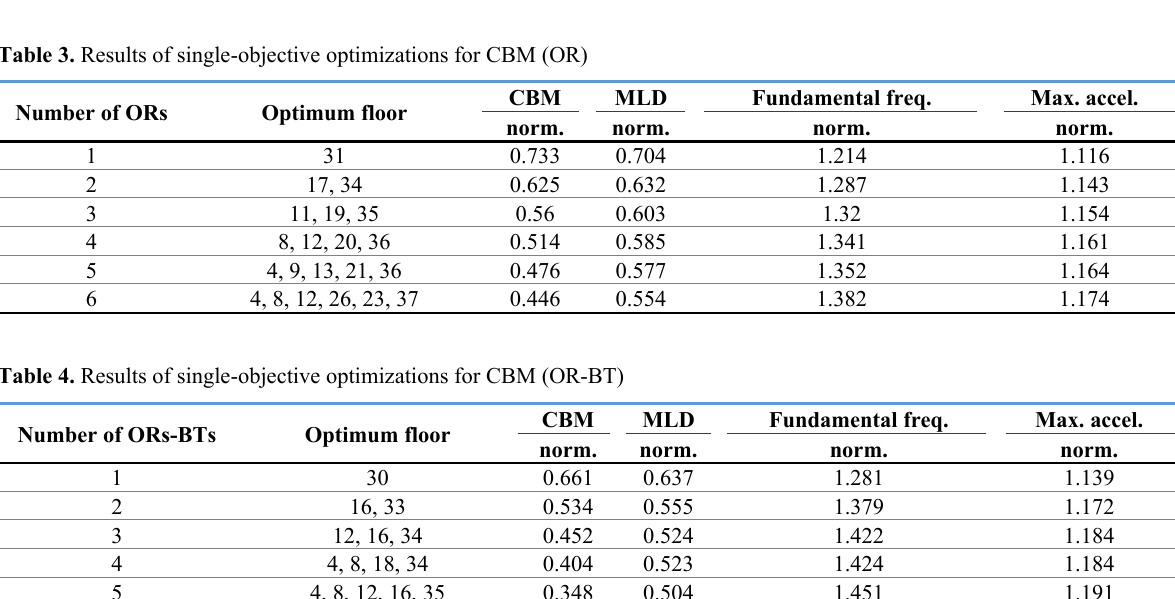
Table 3. Results of single-objective optimizations for CBM (OR) CBM MLD Fundamental freq. Max. accel. Number of ORs Optimum floor norm. norm. norm.